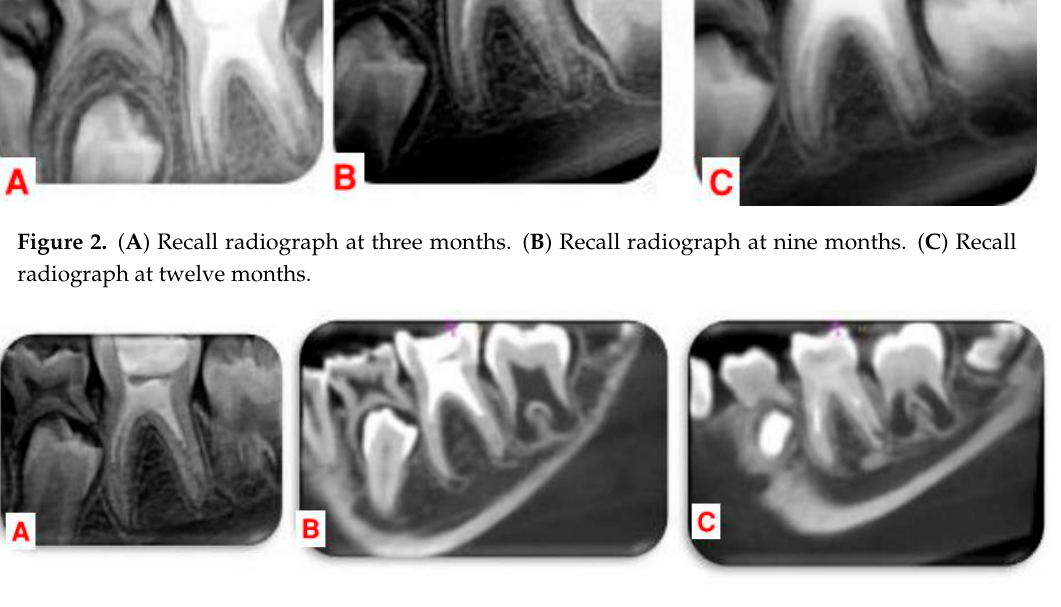
Figure 3. Radiographs at two years ( A ) Recall 2D radiograph at two years. ( B , C ) cone-beam computed tomography (CBCT) images in oblique view of the mesial and distal roots.